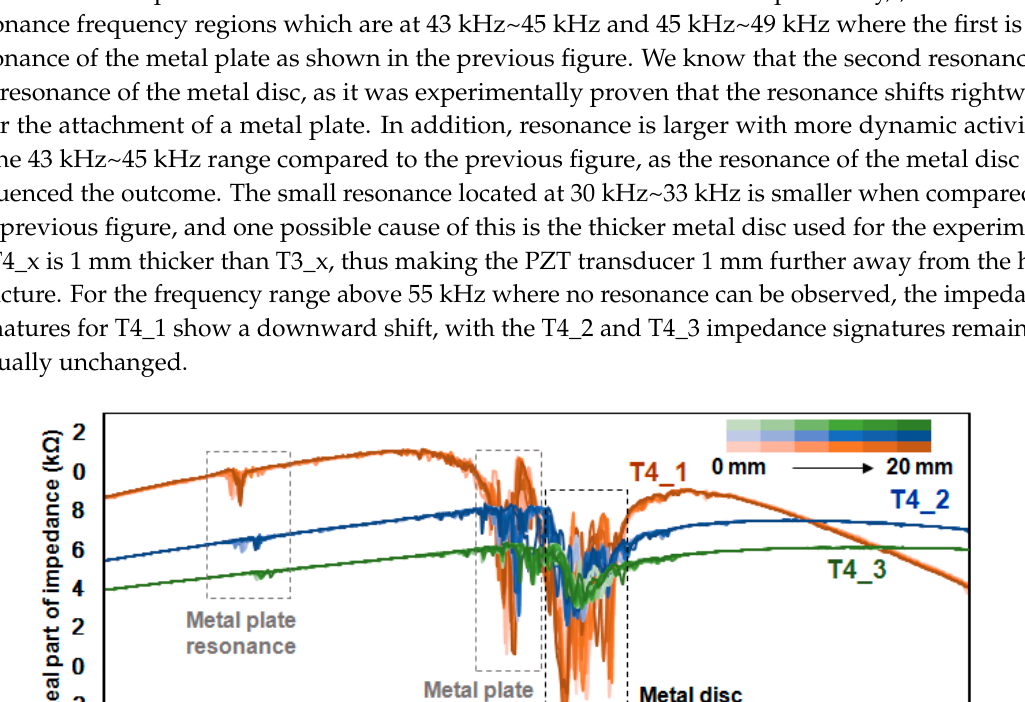
Figure 8. Impedance signatures for the T5_1, T5_2 and T5_3 experiment.